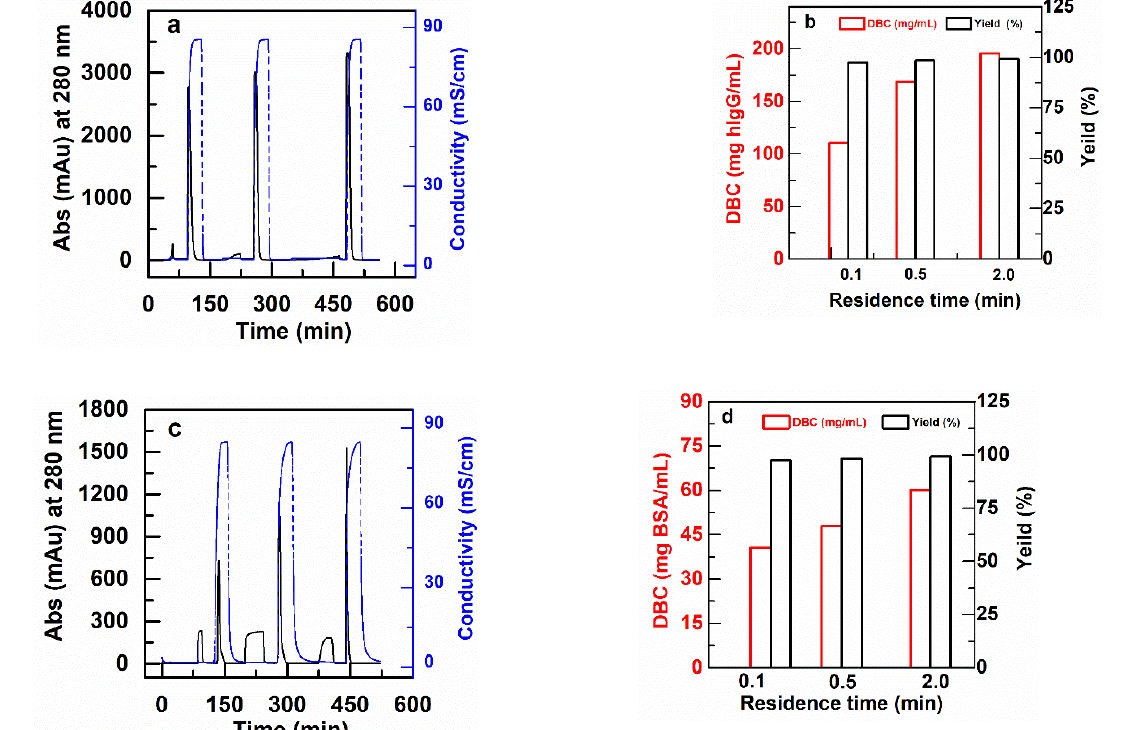
Figure 6. Typical chromatograms for DBC measurement of membrane packed columns (2.5 cm I.D) for RT of 0.1, 0.5 and 2.0 min. ( a ) PBT-GMA-SO 3 membrane column (feed: 2 mg hIgG/mL) and ( b ) DBC for hIgG together with recovered yield (eluted vs. bound), ( c ) PBT-GMA-DEA membrane column (feed: 2 mg BSA/mL), and ( d ) DBC for BSA with recovered yield. Table 3. Comparison of the DBC of BSA (for AEX) or hIgG (for CEX) at different feed concentrations and RTs.